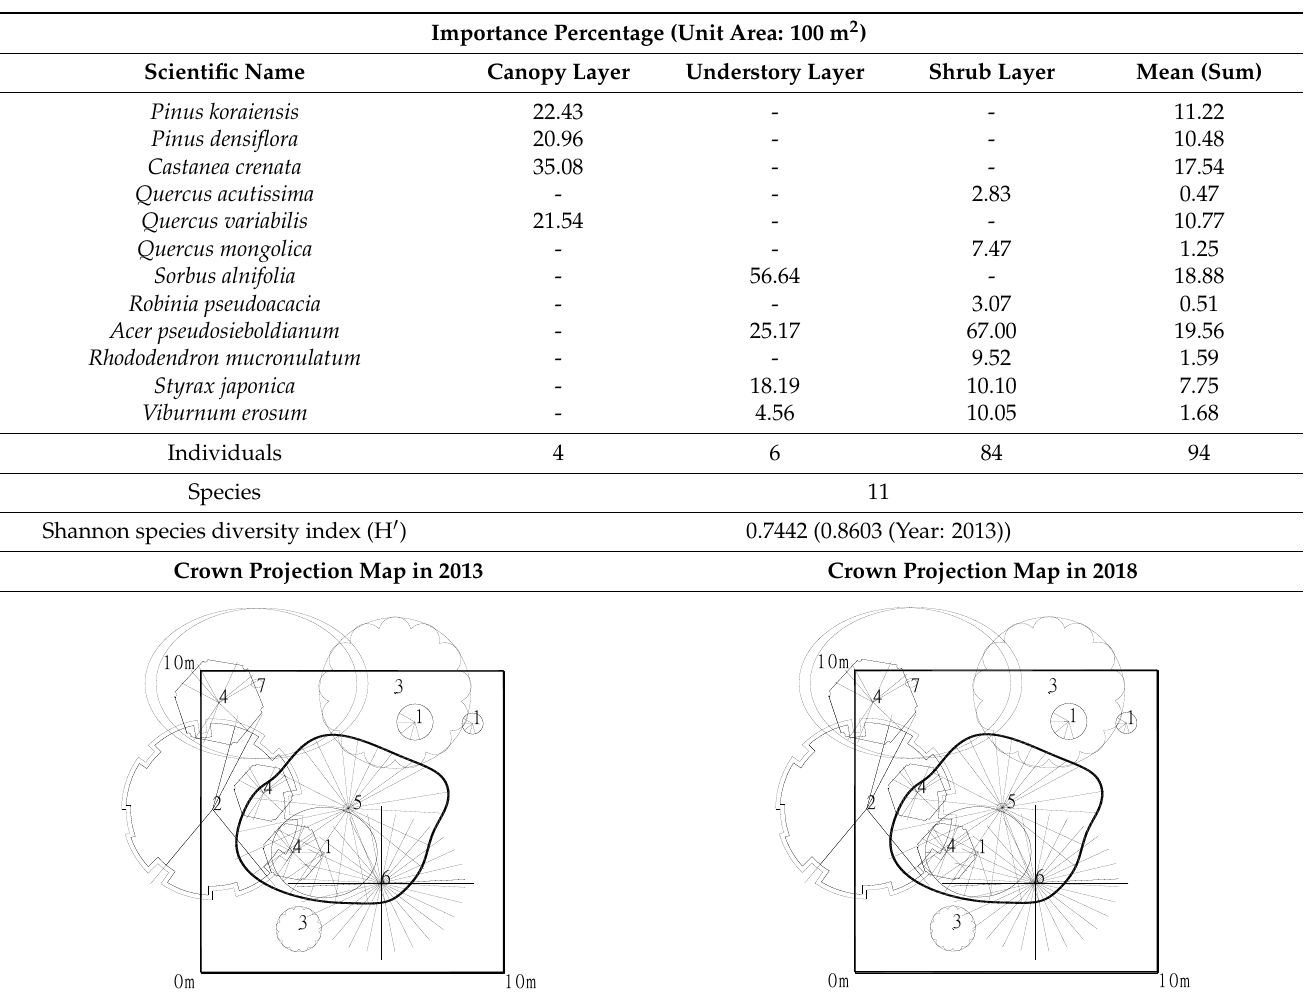
Table 5. Plant community structure of the Pinus densiflora — Pinus koraiensis — Quercus variabilis community (survey plot no. 12) in the forest of the Changdeokgung Rear Garden.